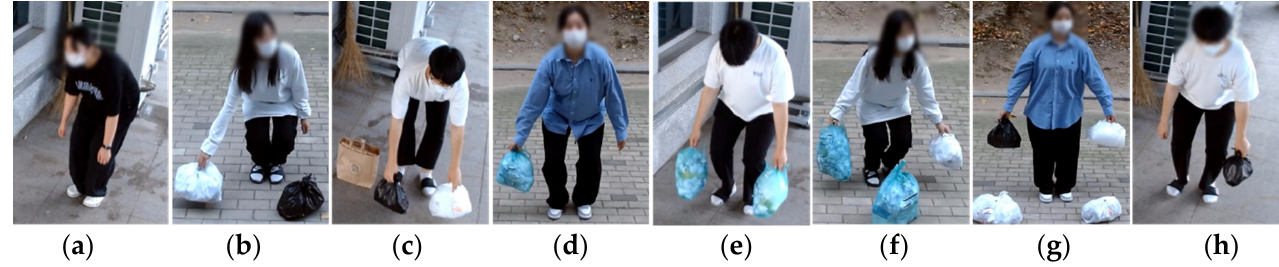
Table 2. Performance comparison of dumping monitoring models per scenario.